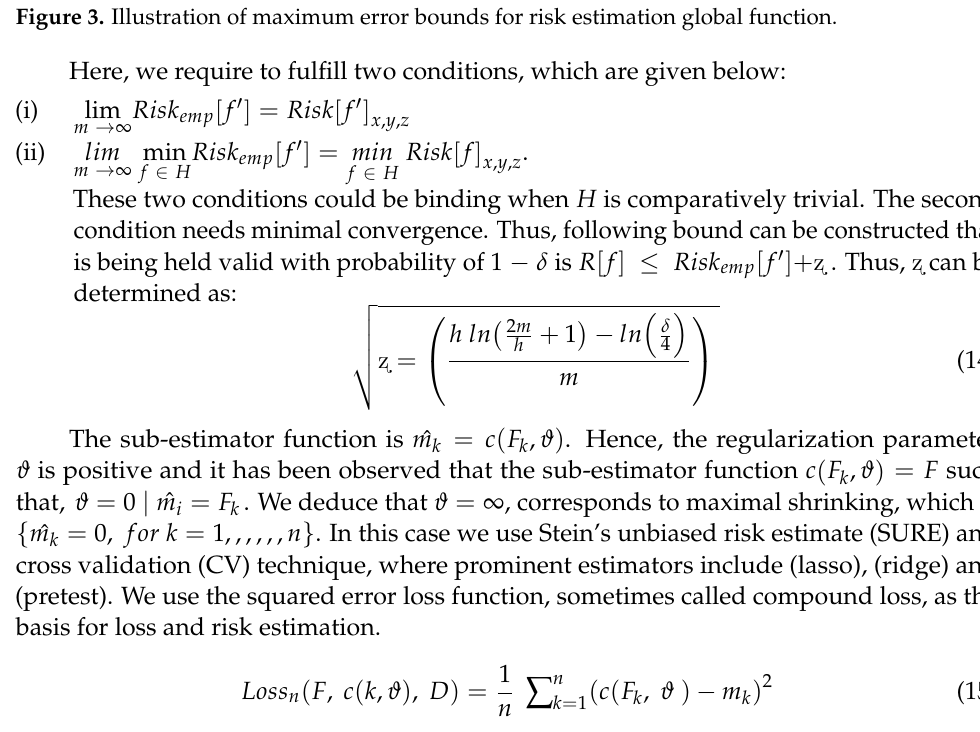
Algorithm 2: Computation of risk estimation process